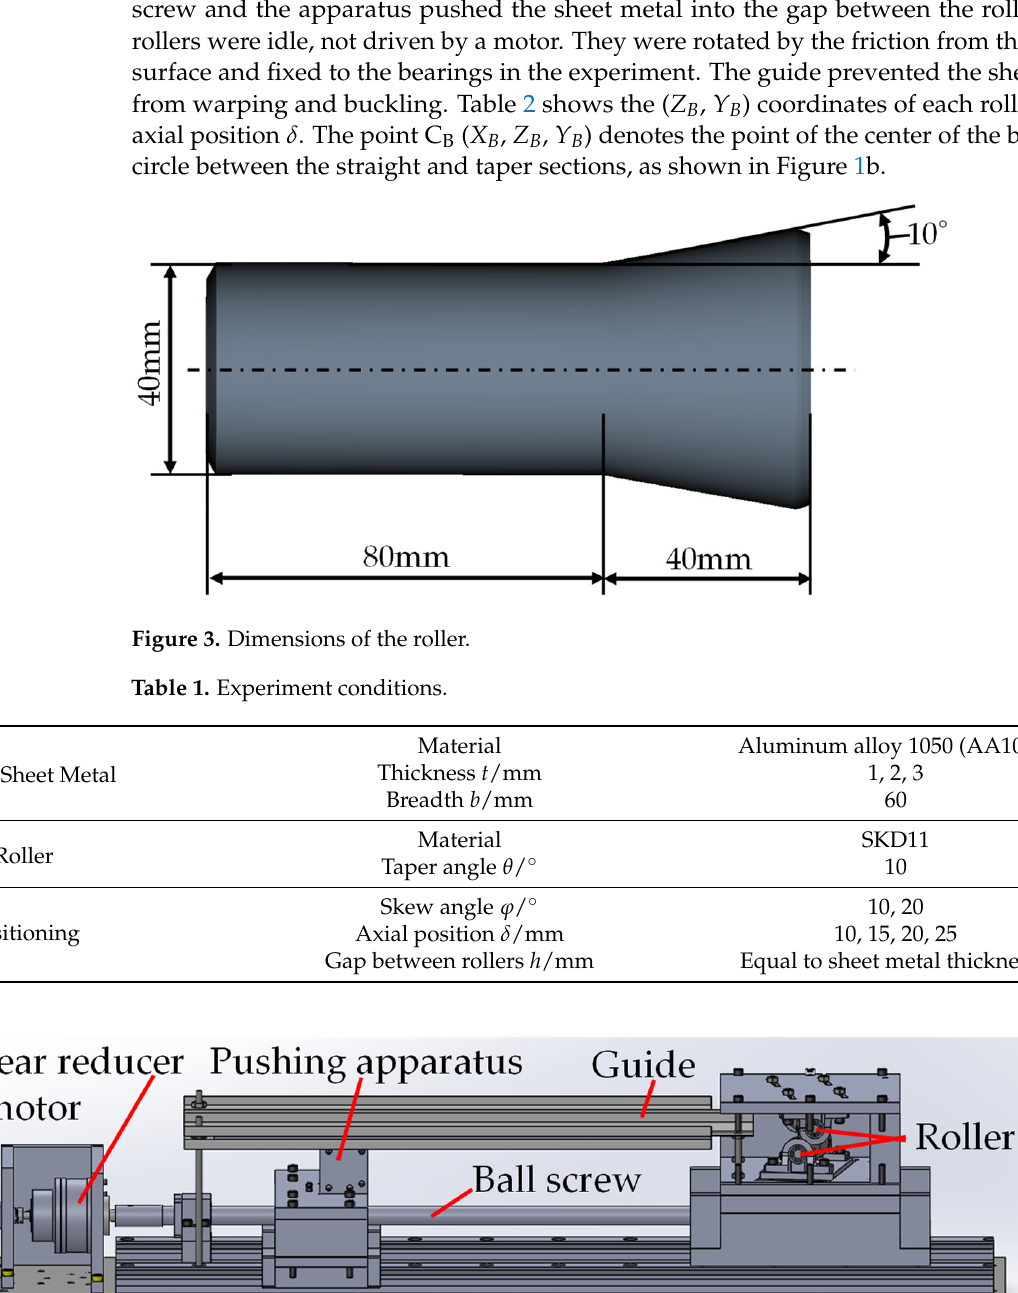
Figure 2. Twisted sheet metal.